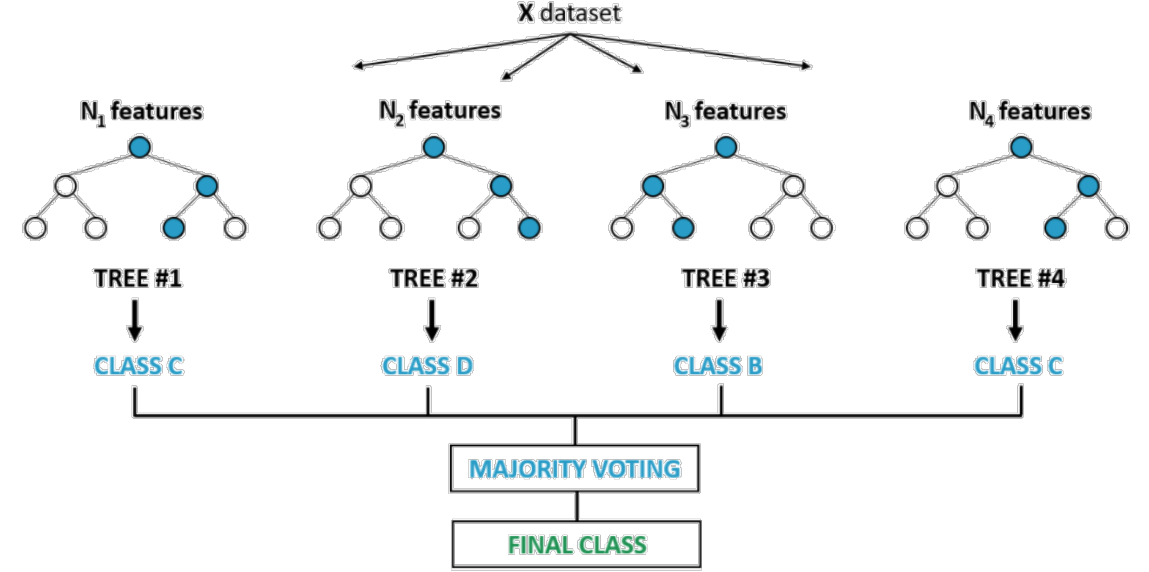
Figure 2. The splitting process on a continuous predictor variable. In the case of a continuous predictor variable, the split is done using a split point. The points where the predictor has a lower value than the split point go to the left. The points with an equal or higher value than the predictor go to the right.